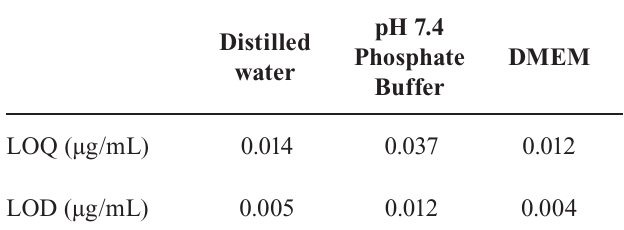
TABLE VIII - Limit of detection and limit of quantitation values for imatinib mesylate